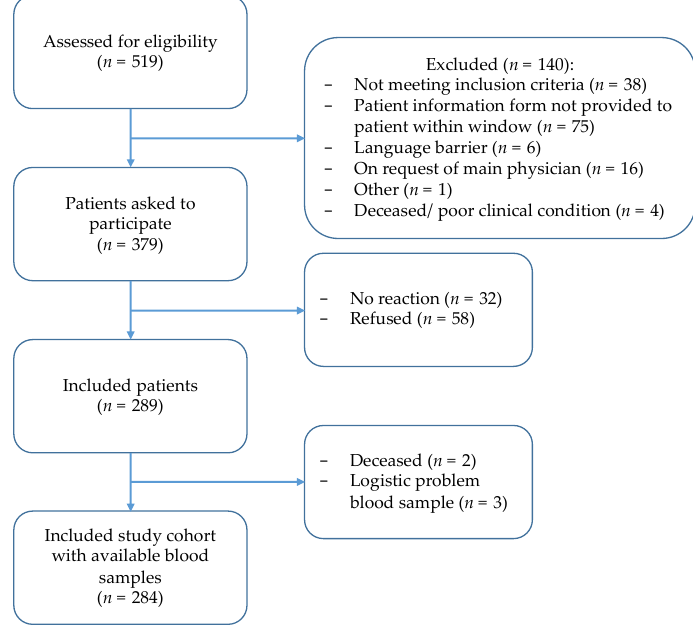
Figure 1. Inclusion flowchart of THYRO-Dynamics study. Table 1. Baseline patient characteristics ( n = 284).